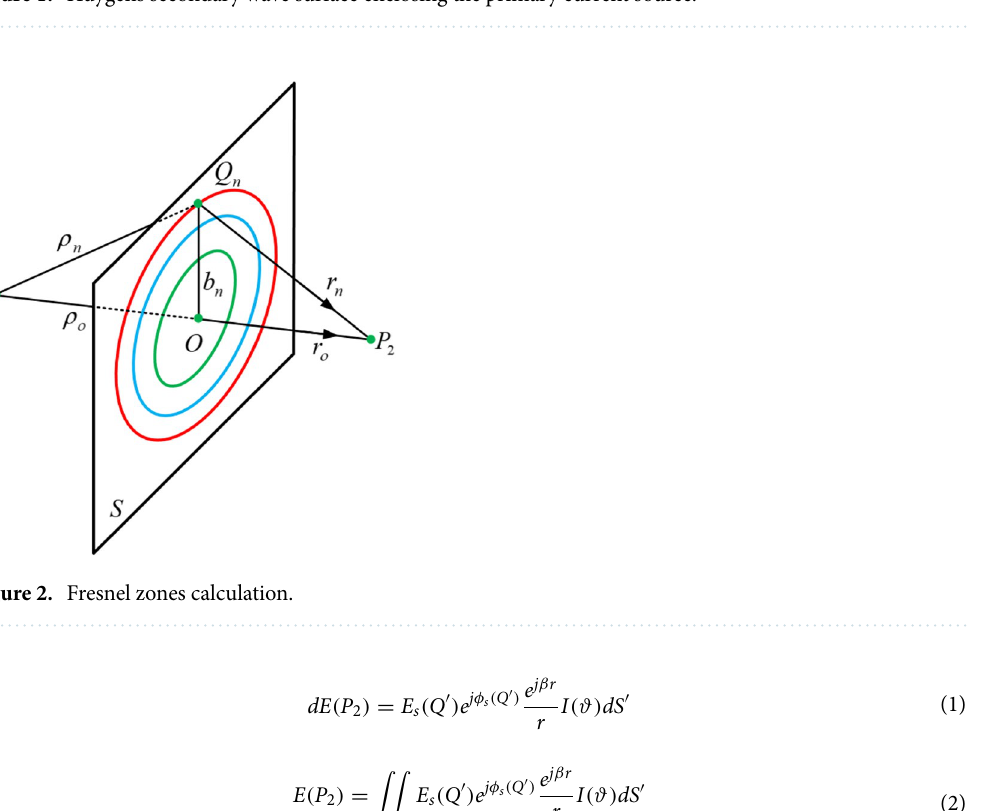
Figure 1. Huygens secondary wave surface enclosing the primary current source.